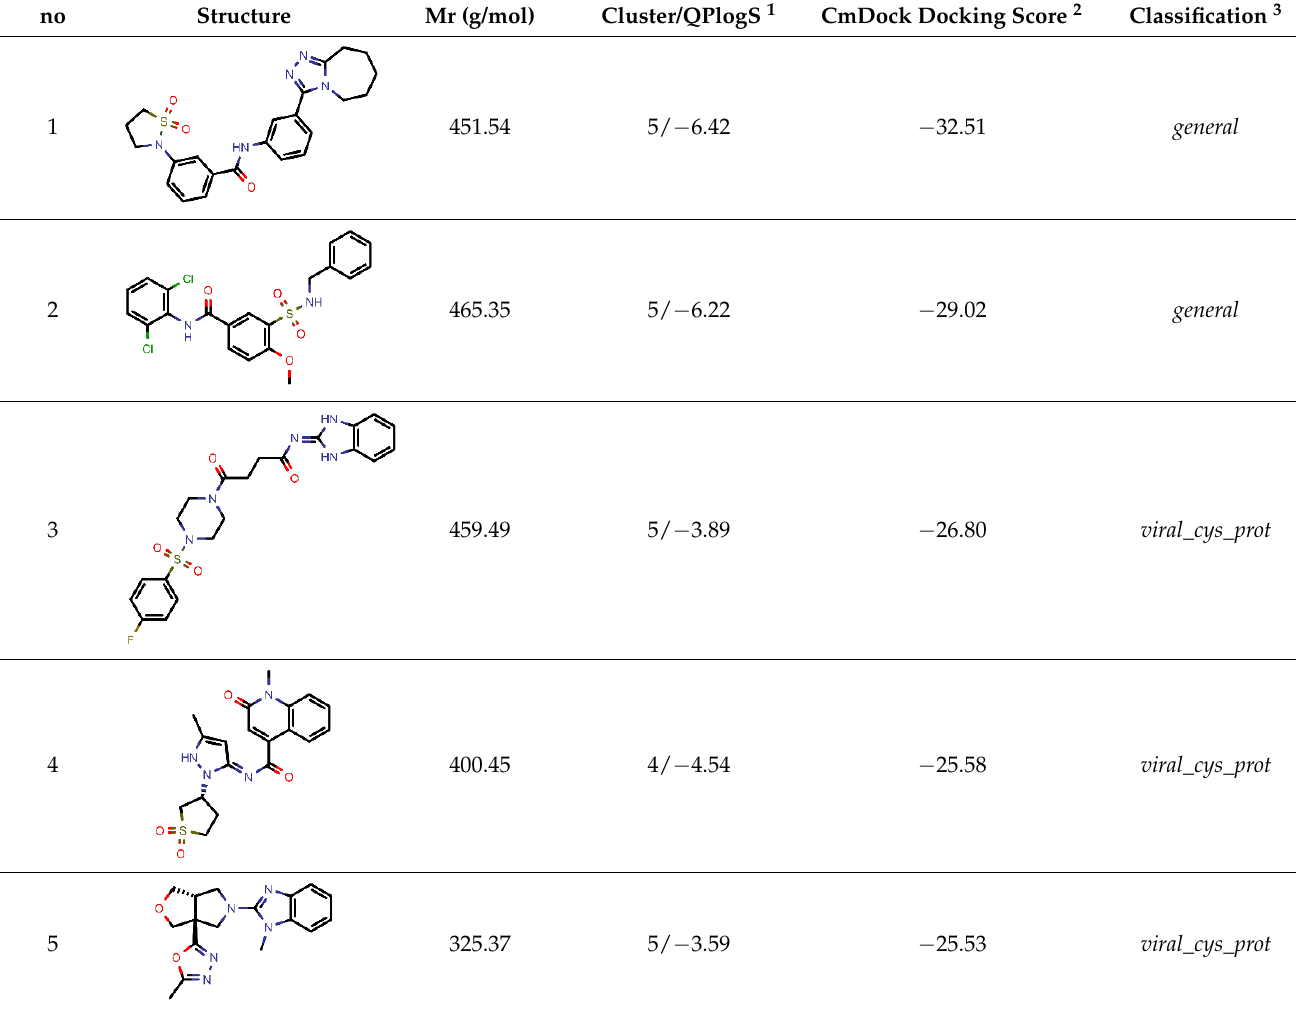
Figure 5. Calculated bound conformations in the 3CL pro active site of the top-scoring hit compounds. Protein is presented in a cartoon model coloured pink with an emphasised molecular surface in light-blue colour. ( A ) ; the reference OEW ligand is presented in stick model cored magenta, while the top-scoring hit is coloured grey. ( B ) the reference OEW ligand is presented in stick model cored magenta while the top 10 scoring compounds are depicted in red-coloured line repre- sentations to emphasise their analogous binding mode in the P1-P2-P3 pockets of the active site. Table 2. Identified top-scoring compounds in the HTVS on the SARS-CoV-2 main protease for further compound prioritisa- tion in biological evaluation experiments.